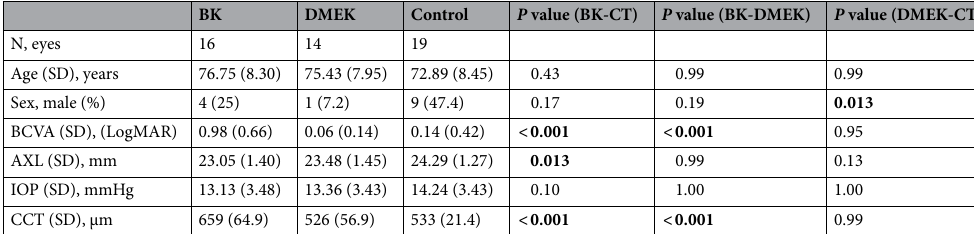
Table 1. Participant characteristics. BK, bullous keratopathy; CT, control; DMEK, Descemet’s membrane endothelial keratoplasty; BCVA, best-corrected visual acuity; IOP, intraocular pressure; AXL, axial length; CCT, central corneal